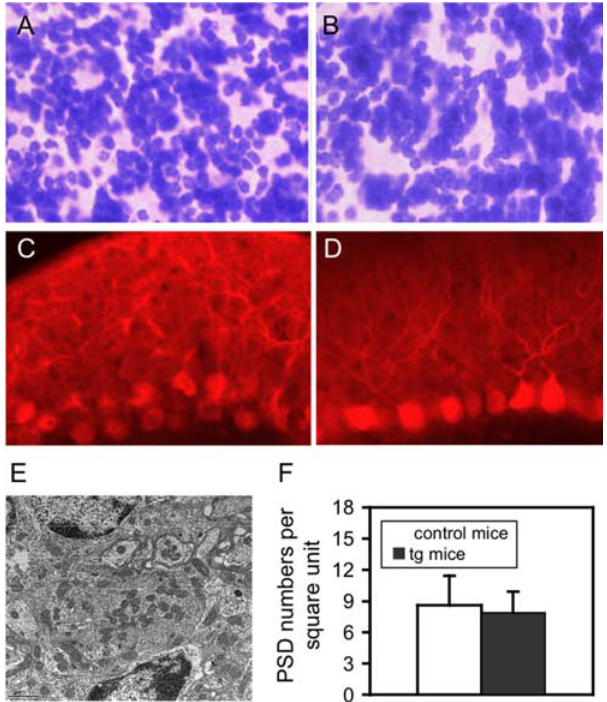
Figure 4. Morphological changes in the cerebellum of tg mice. A and B. Nissl straining of sagital sections from control (A) and tg (B) mice. No observable difference, either in general morphology of granule cells or cell number in granule cell layer, was found between them. C and D. Immunohistological staining with DK-28 (Sigma). No obviously morphological changes could be found in the Purkinje cell layer and the molecular cell layers between control (C) and tg mice (D). E. A typical glomerulus from cerebellar section from a tg mouse. The bar in left corner was 1 m m. F. Quantitative analysis of number of mossy fiber/granule cell synapses. No significant difference was found between control and tg mice. Data are expressed as mean 6 SD.